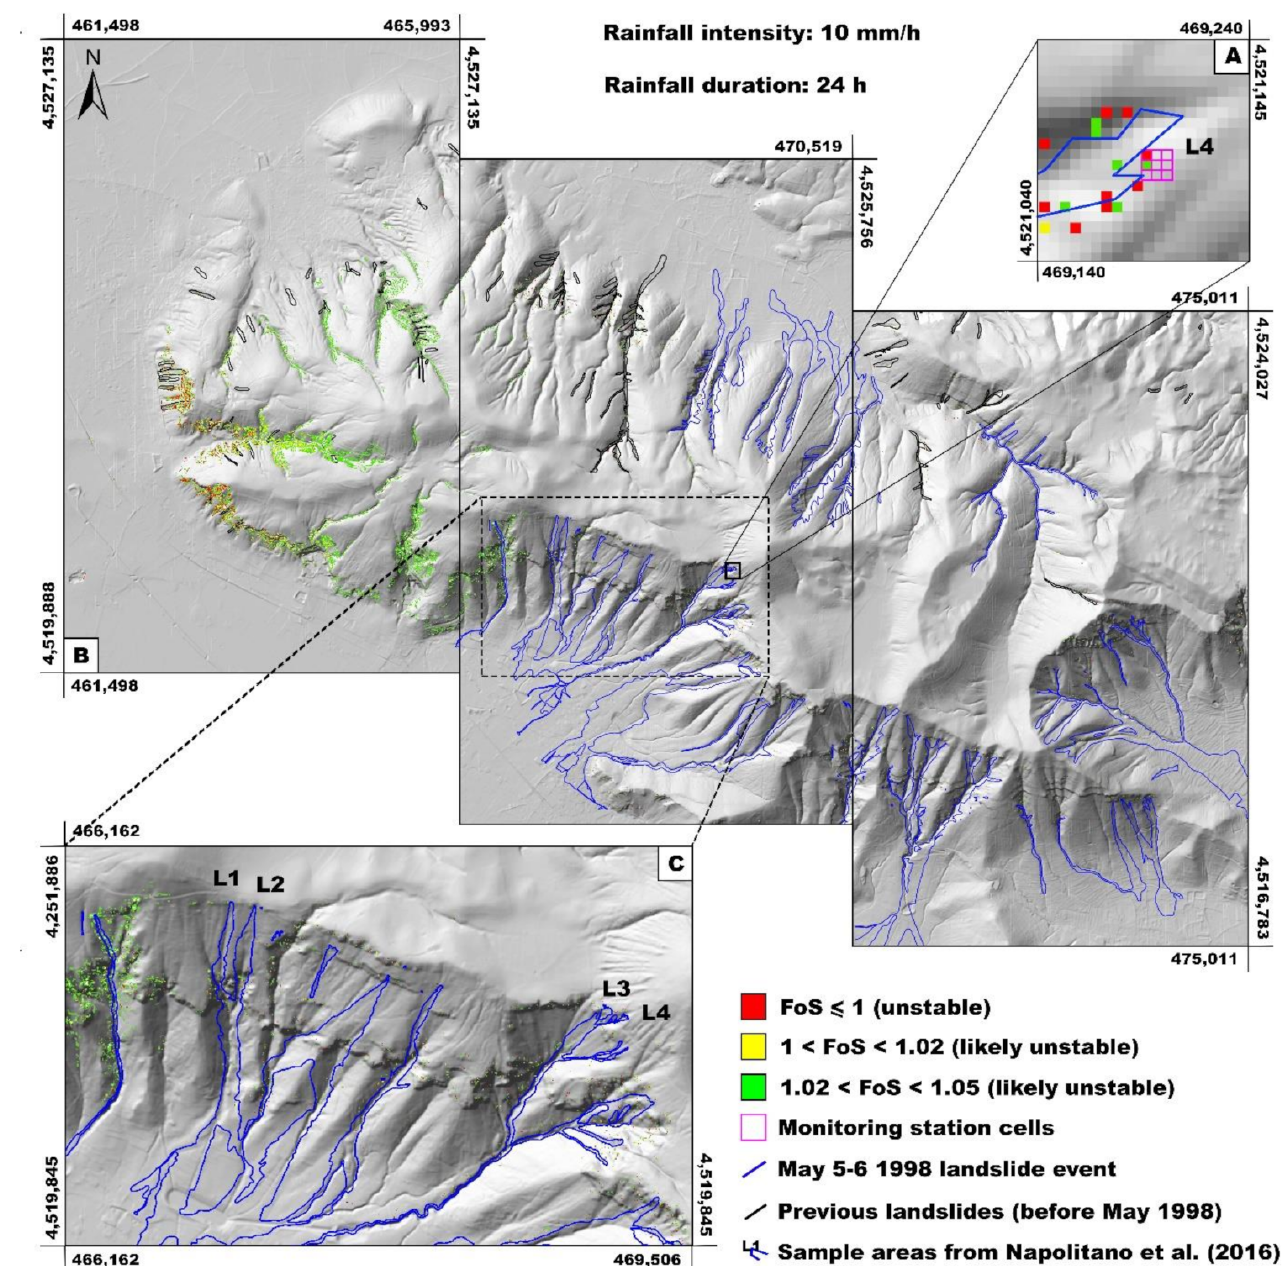
Figure 10. Distributed slope stability maps, at site–specific ( A ) and the slope ( B ) scales, resulting from a modeled constant rainfall intensity of 10.0 mm/h for 24 h. Unstable and likely unstable cells were compared within sample areas ( C ) L1, L2, L3 [77], L4 and the entire Sarno Mountains landslide inventory comprising the May 1998 Sarno landslide event. Monitoring station cells used for local scale modeling and L4 threshold definition are also shown ( C ) (WGS84/UTM